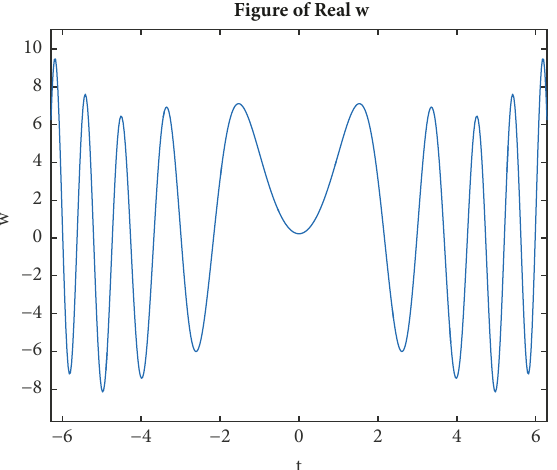
Figure 6: 𝑥 = 0.9 , 𝑙 1 = 0.3 , 𝑙 2 = 0.5 , 𝑙 3 = 0.8 , 𝑚 1 = 1 , 𝑚 2 = 2 , 𝑦 = 3 , and 𝑡 ∈ [−6,6]